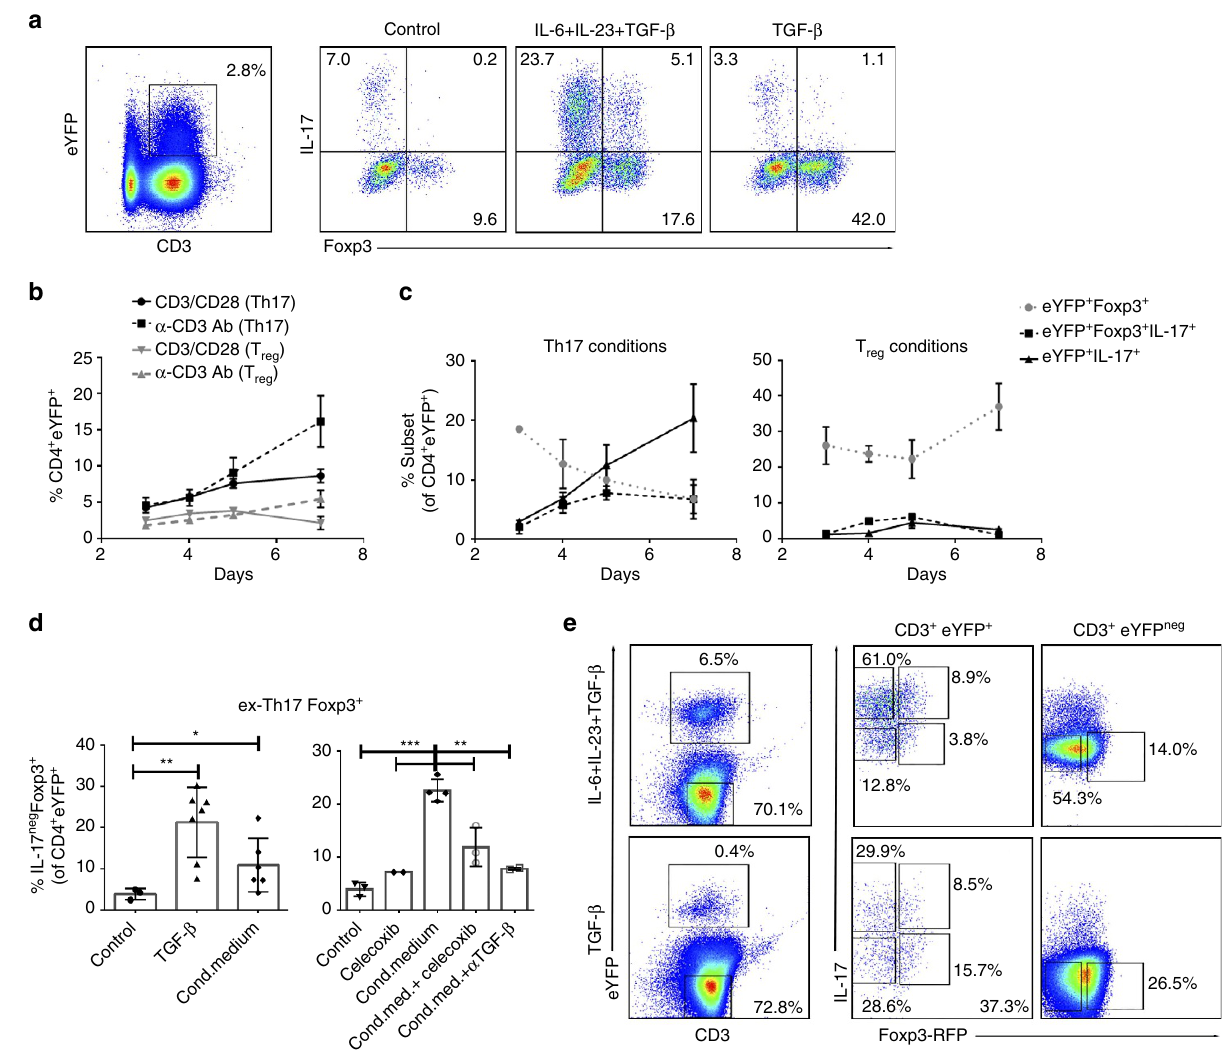
Figure 4 | Tumour-associated TGF- b and PGE 2 promote ex-Th17 Foxp3 þ IL-17A neg cells. Splenocytes from IL-17a Cre R26R ReYFP fate reporter mice were stimulated with CD3/CD28 microbeads under control, Th17 (IL-6, IL-23, TGF- b ) and T reg (TGF- b )-driving conditions. ( a – c ) Representative flow cytometry analysis (day 3, a ) and time-dependent induction ( b , c ) of eYFP þ cells ( b ) and Th17–T reg subsets ( c ) from IL-17a Cre R26R eYFP fate reporter mice (CD4 þ gated). Cells were cultured in the presence of Th17 (IL-6, IL-23 and TGF- b )- and T reg (TGF- b )-driving conditions and analysed on days 3, 4, 5 and 7 by flow cytometry for the expression of eYFP. The fluorescence-activated cell sorting (FACS) gating strategy of live cells is presented in Supplementary Fig. 8e ( b ) and the expression of Foxp3 and IL-17A production by eYFP þ cells is shown. Similar results were obtained in an additional independent experiment. ( d ) CD4 þ Tcells from IL-17a Cre R26R ReYFP reporter mice were cultured under T reg (TGF- b )-driving conditions or conditioned medium of ID8A cells (aggregate data of 3–7 independent experiments; mean ± s.d., left). COX2 inhibitor celecoxib was added during preparation of conditioned medium and celecoxib and TGF- b blocking antibody were added to cell cultures during CD3/CD28 stimulation (right). ( e ) Representative flow cytometry analysis (day 7) of CD4 þ Tcells from Th17 eYFP -Foxp3 mRFP fate reporter mice cultured in the presence of Th17/T reg (IL-6, IL-23 and TGF- b , 3 days and TGF- b , þ 4 days)- and T reg (TGF- b , 7 days)- driving conditions. The FACS gating strategy of live cells is presented in Supplementary Fig. 8e. All data are mean ± s.d. * P o 0.05, ** P o 0.01 and *** P o